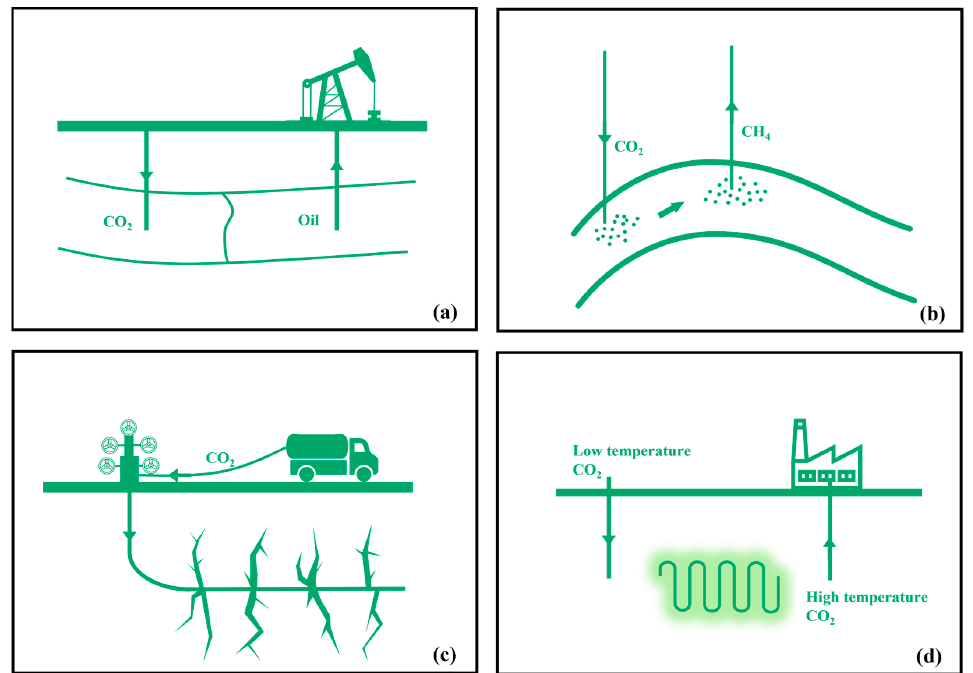
Figure 1. The diagrammatic sketch of geological CCUS technologies. ( a ) CO 2 -enhanced oil recovery; ( b ) CO 2 -enhanced gas recovery; ( c ) CO 2 fracturing; ( d ) CO 2 -enhanced geothermal system (modified from [16–19]).